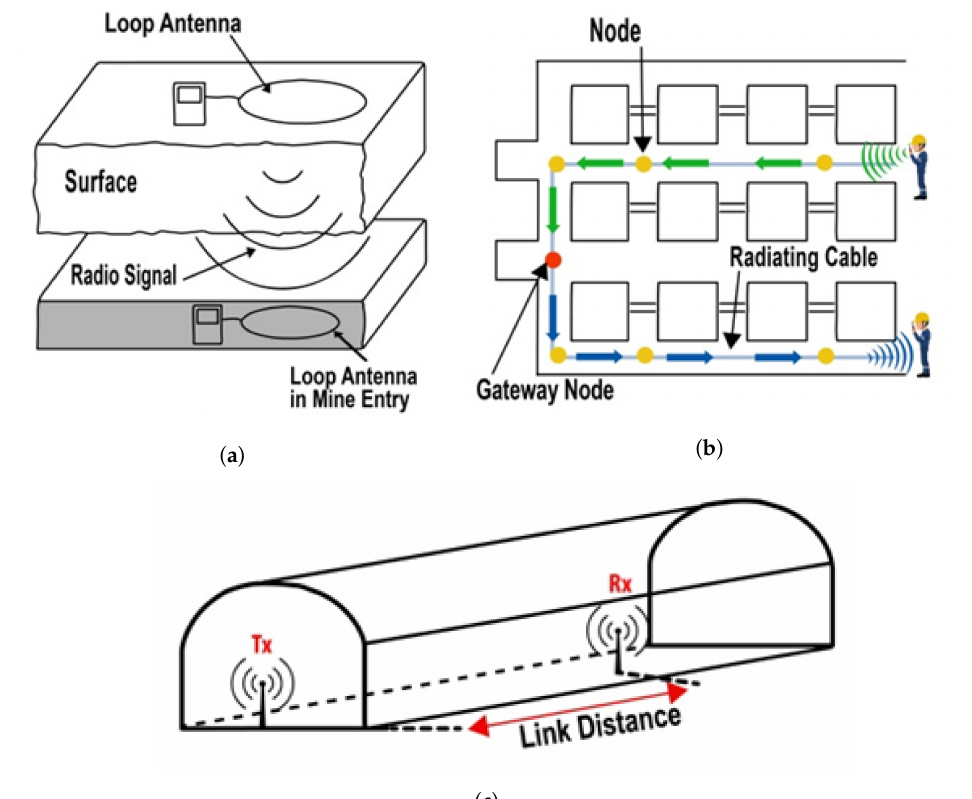
Figure 2. Pictorial presentation of conventional communication methods ( a ) through-earth, ( b ) through-wire, and ( c ) through-air communication